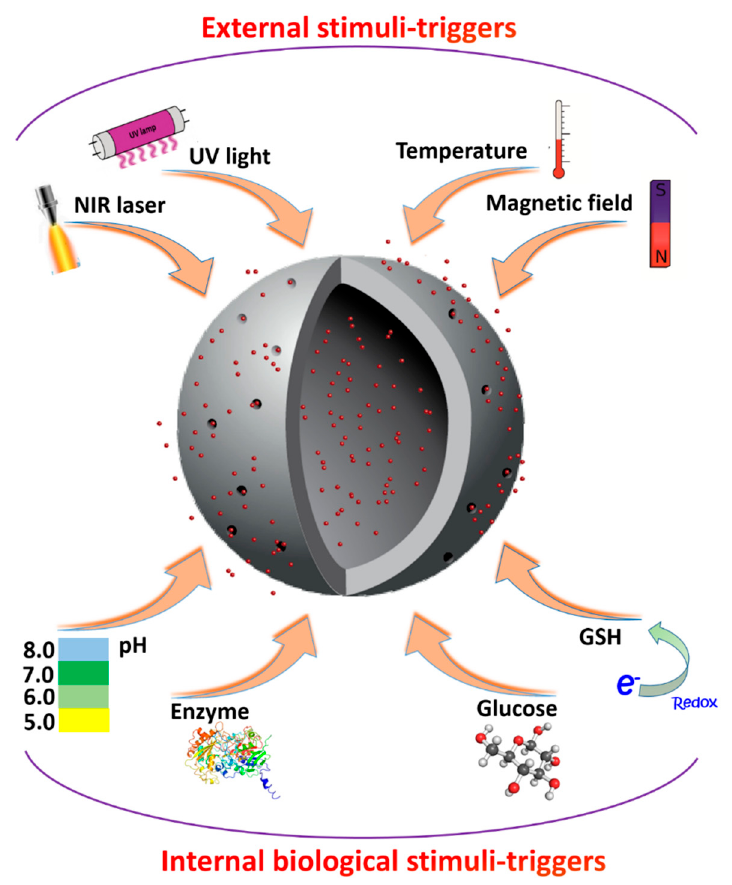
Figure 3. Schematic presentation of a variety of external and internal triggering mechanisms for delivery of bioactive compounds using porous silica-based